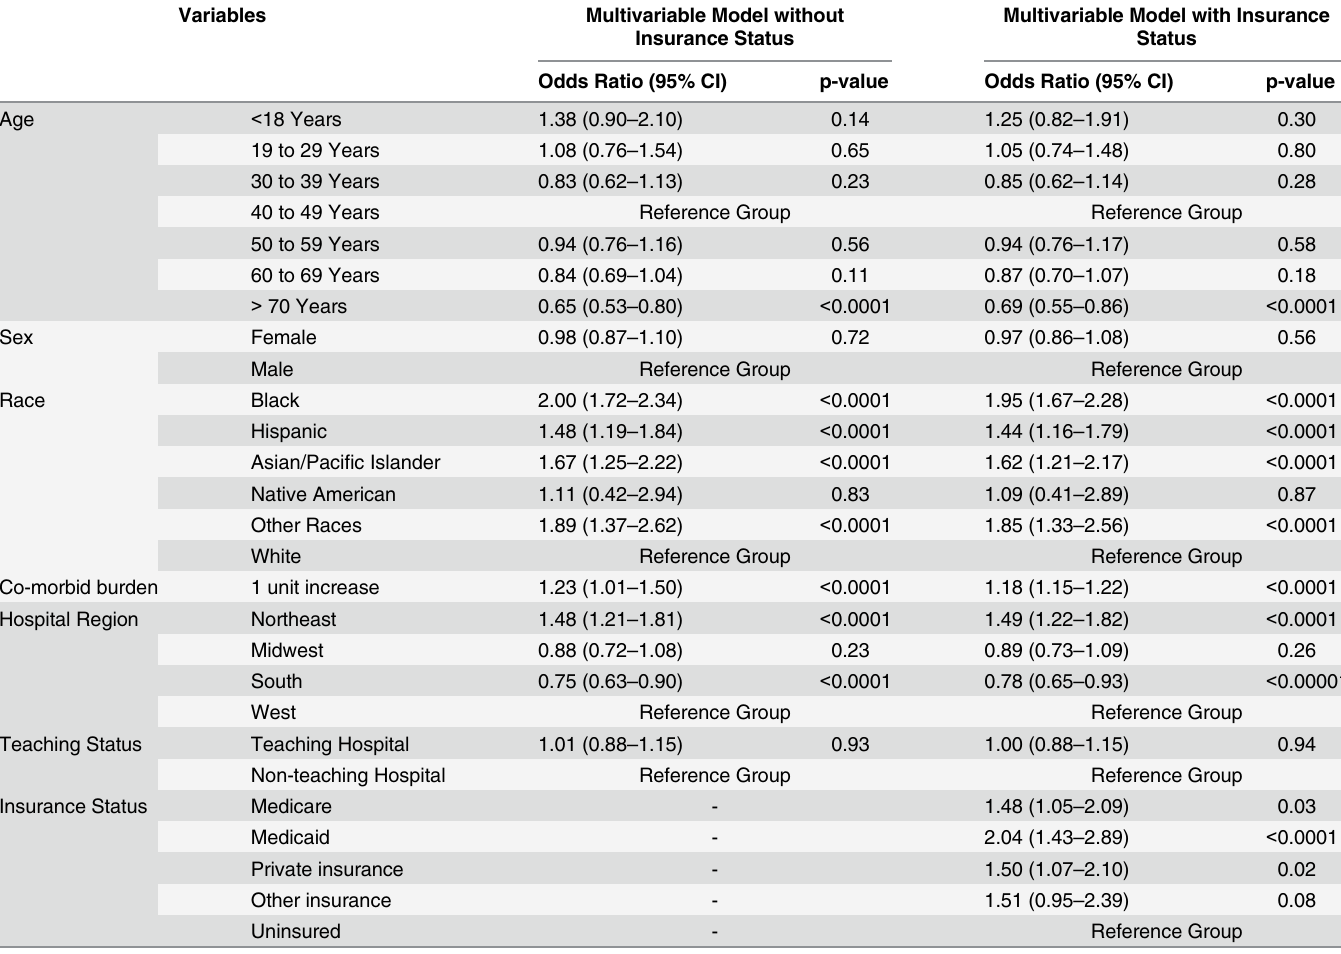
Table 2. Multivariable Logistic Regression for Performance of